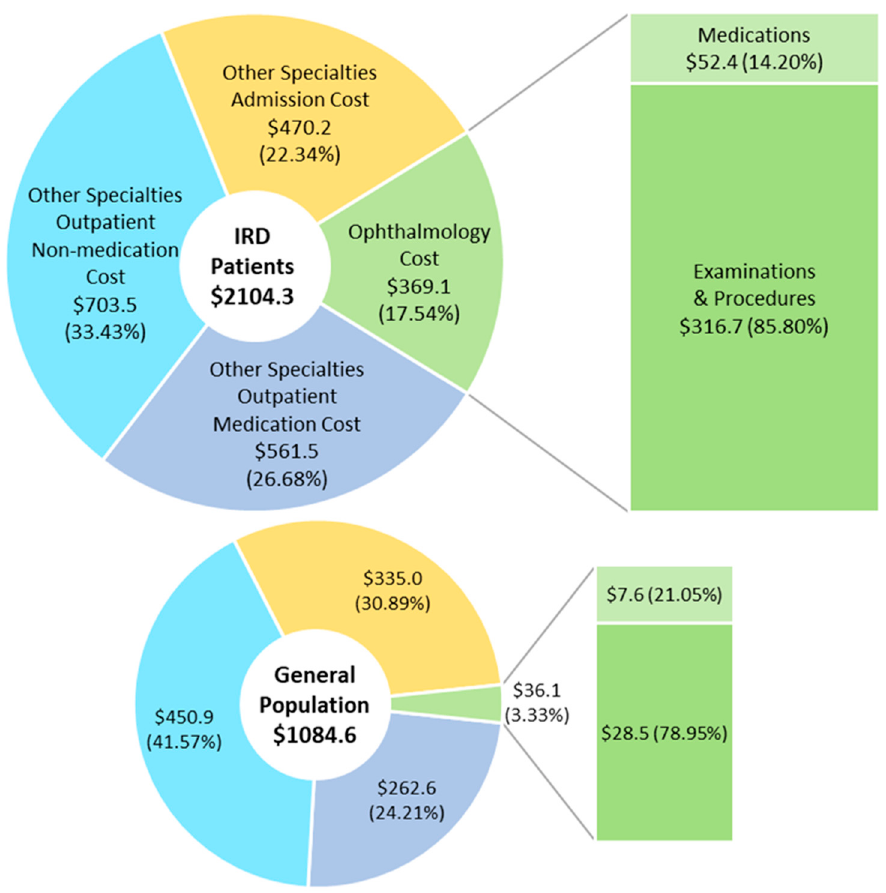
Figure 4. Mean yearly medical costs of patients with inherited retinal degenerations and the general population. Abbreviations: IRD, inherited retinal degeneration.